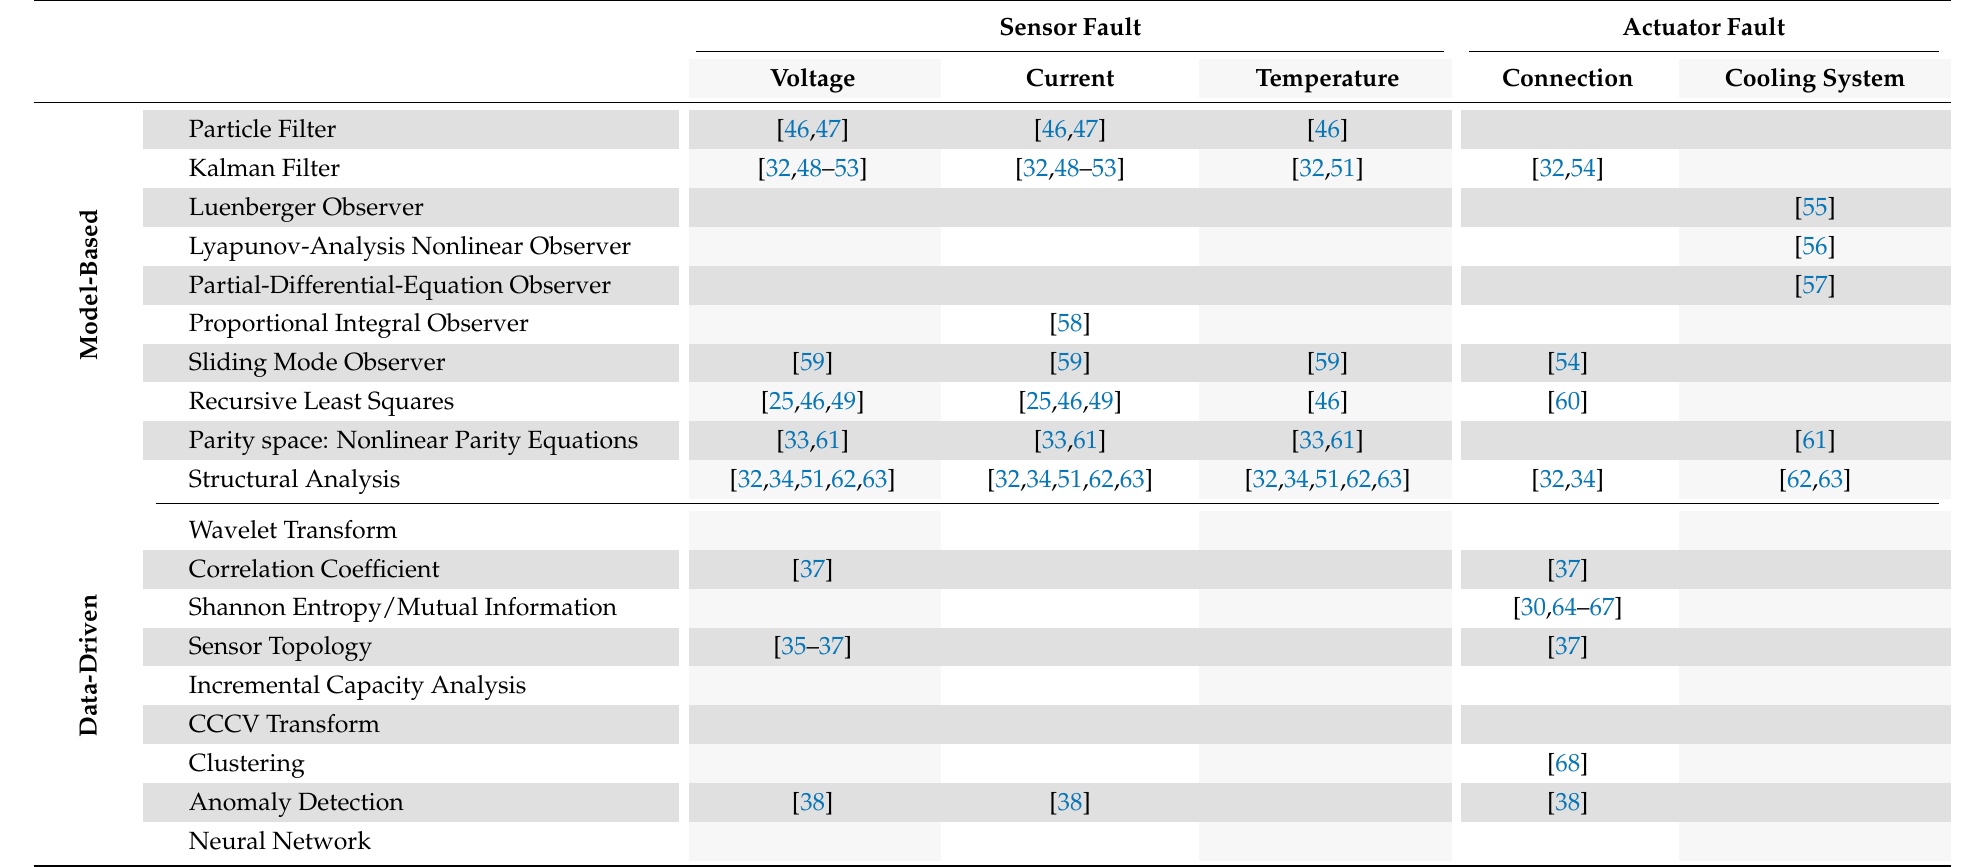
Table 1. Overview of the literature related to fault diagnosis of external faults